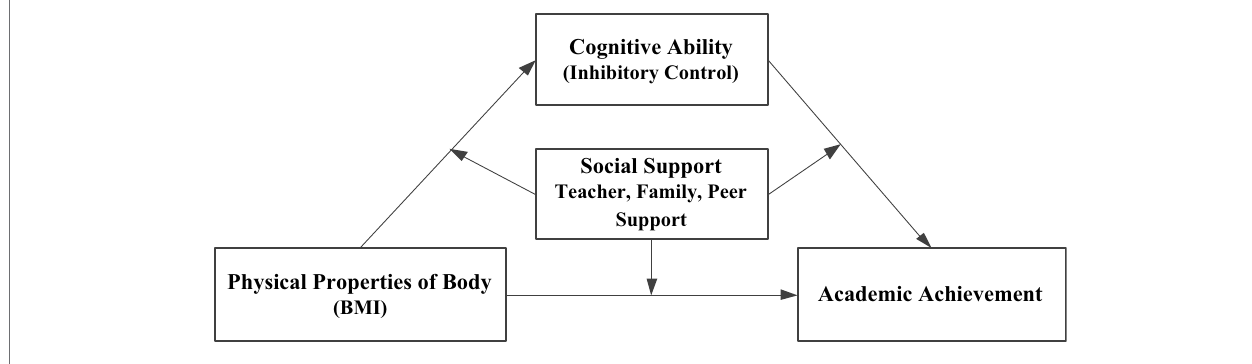
FIGURE 1 | Concept